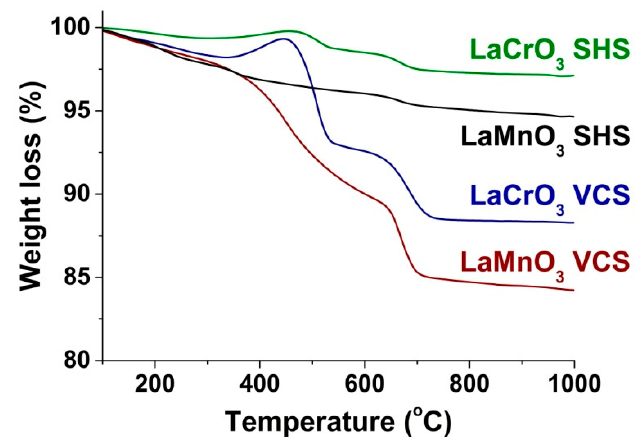
Figure 8. Thermogravimetric analysis of LaMnO 3 and LaCrO 3 obtained in the different combustion regimes (air, 20 mg, 10 °C/min).